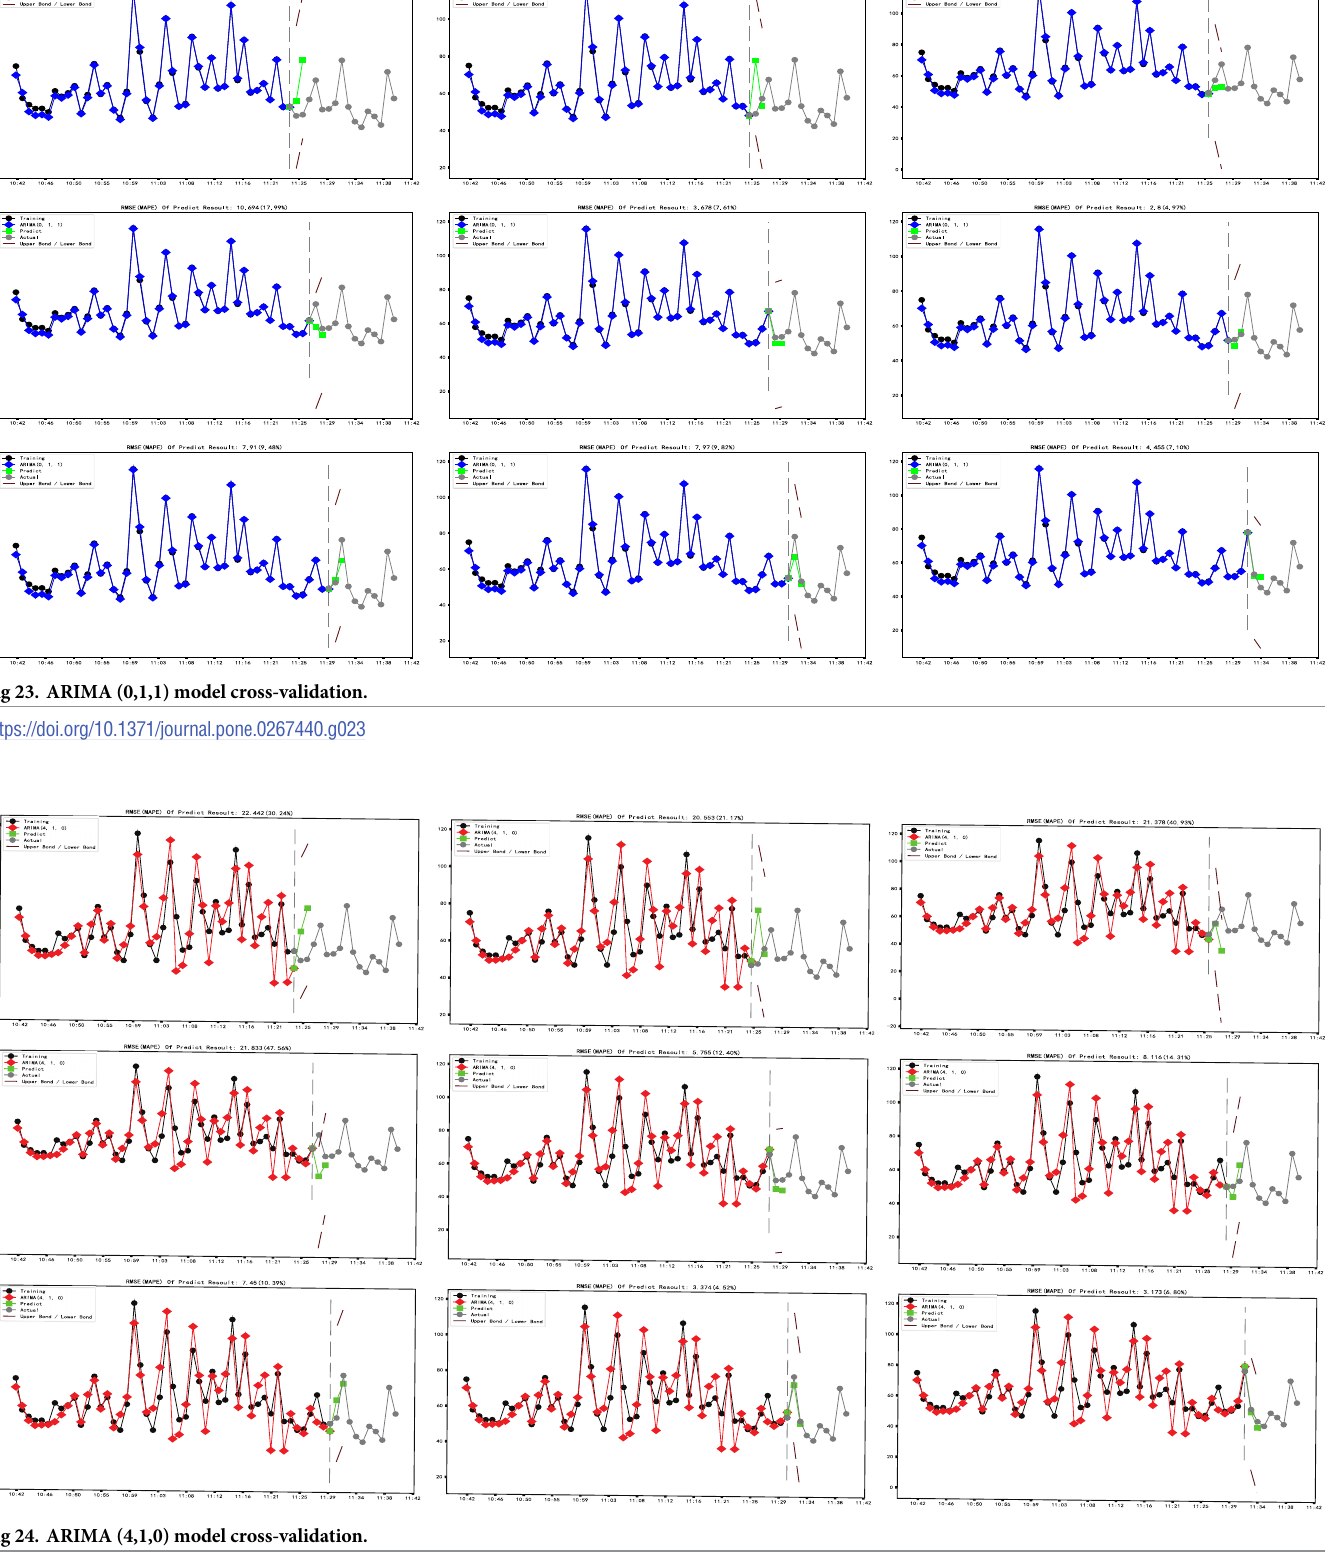
PLOS ONE | https://doi.org/10.1371/journal.pone.0267440 May 5,